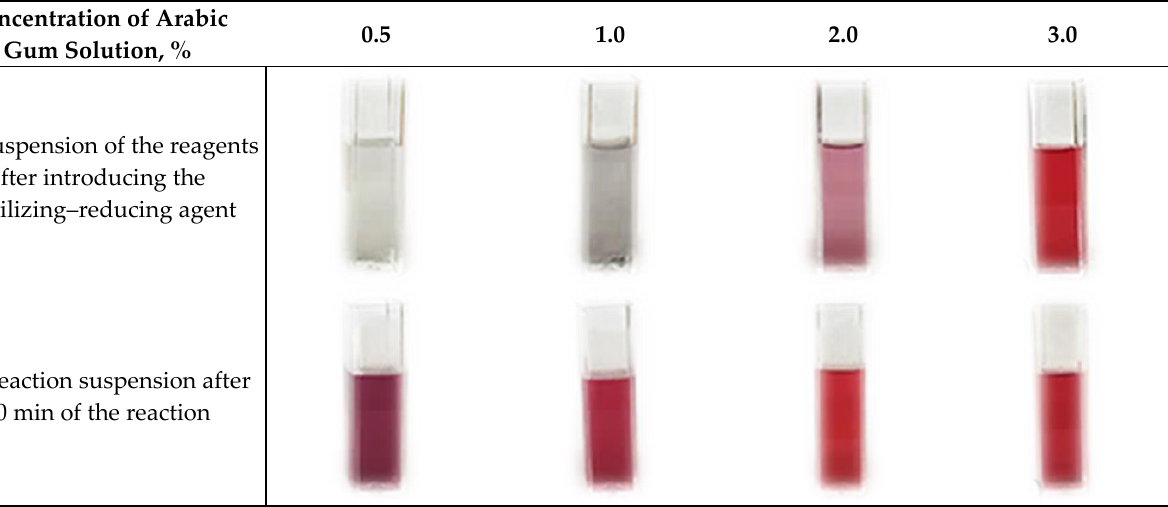
Figure 2. Color changes in the reaction suspensions during the synthesis of nanogold performed using Arabic gum solutions of various concentrations.